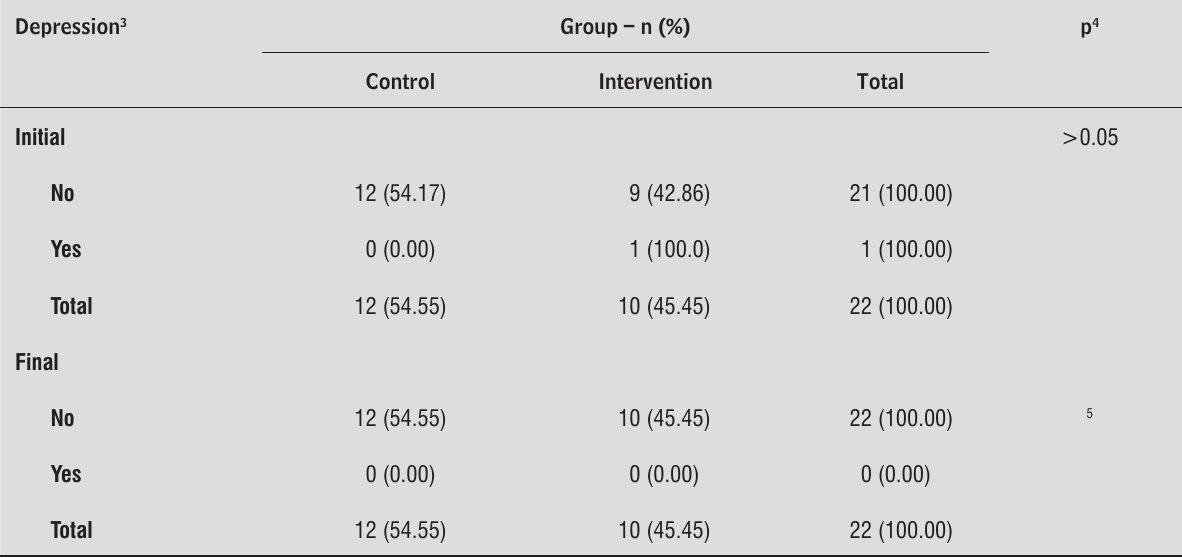
Table 3 - Distribution of occurrence (n) of depression in percentages according groups Depression 3 Group – n ( % ) p 4 Control Intervention